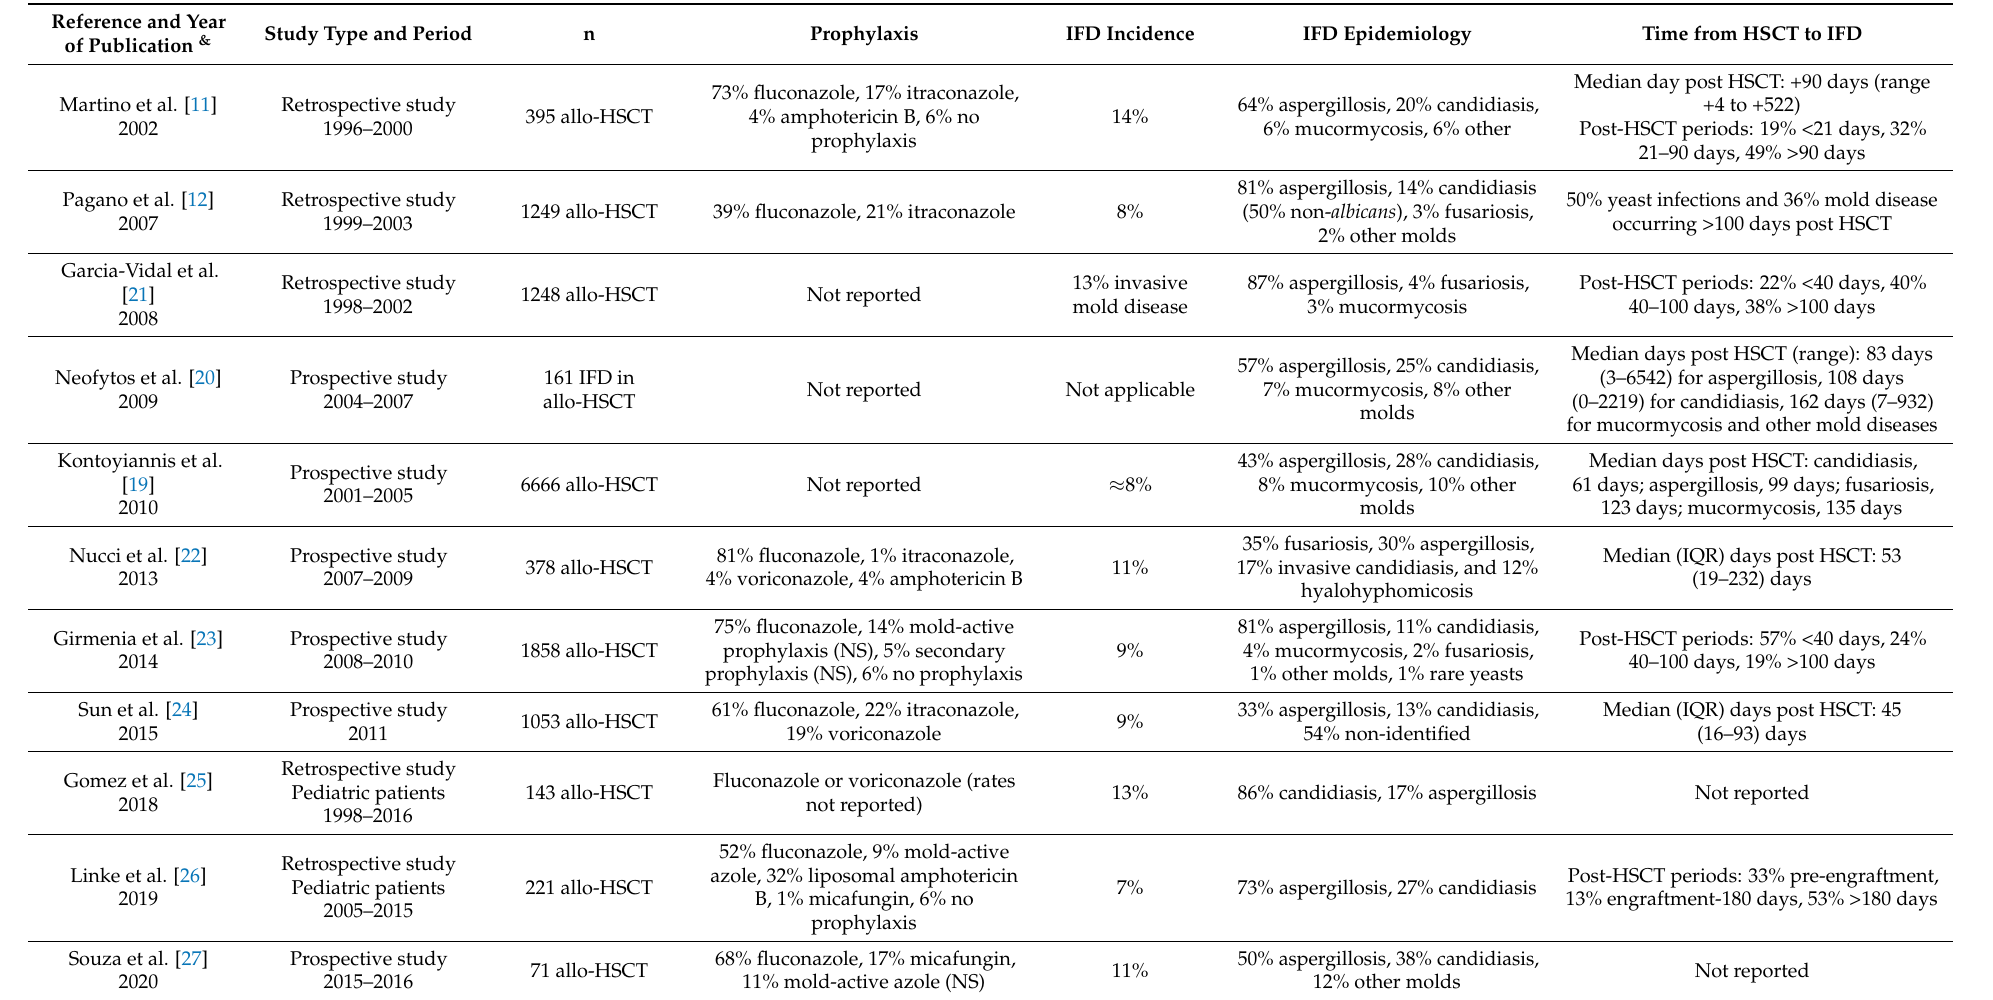
Table 1. Important studies regarding invasive fungal disease in allogenic HSCT